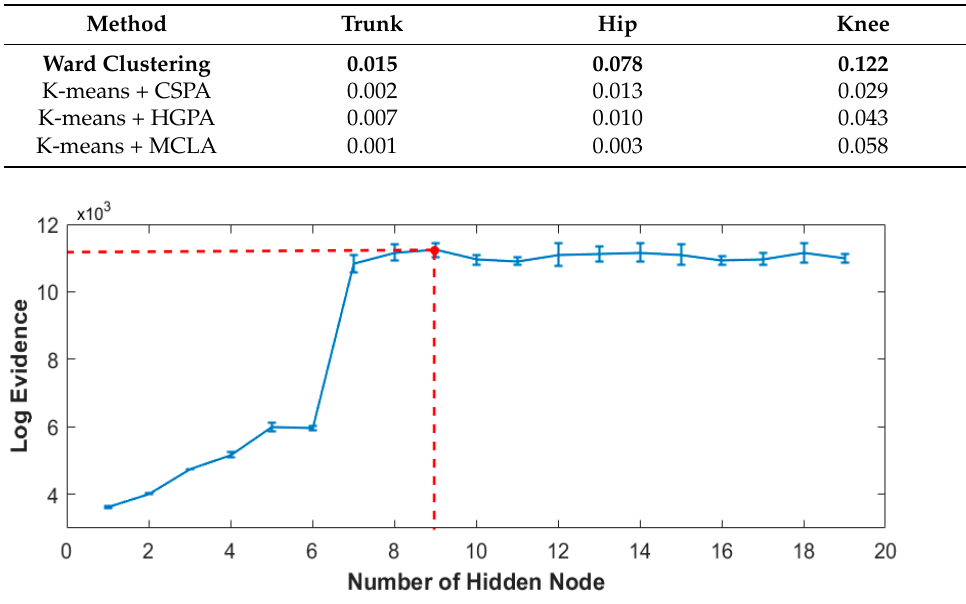
Table 4. Partial eta squared effect size result between different methods.